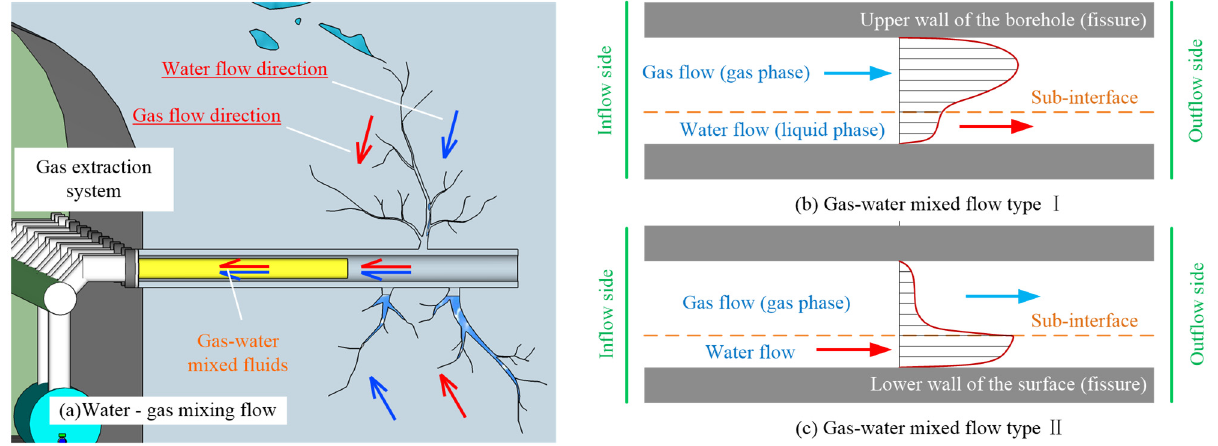
Figure 16. Schematic diagram of water–gas mixing flow within the perihole-fractured coal body.